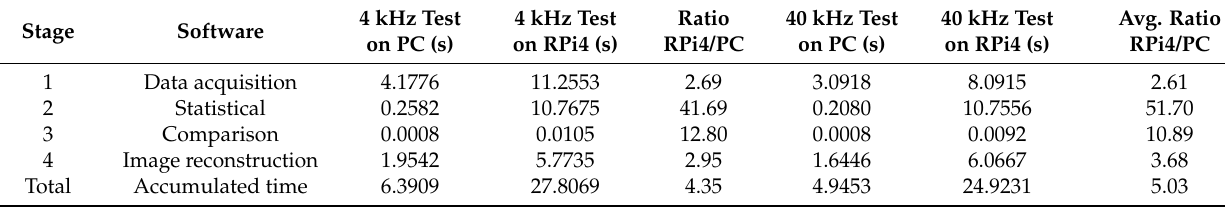
Table 4. Comparison between software execution times on a PC and the